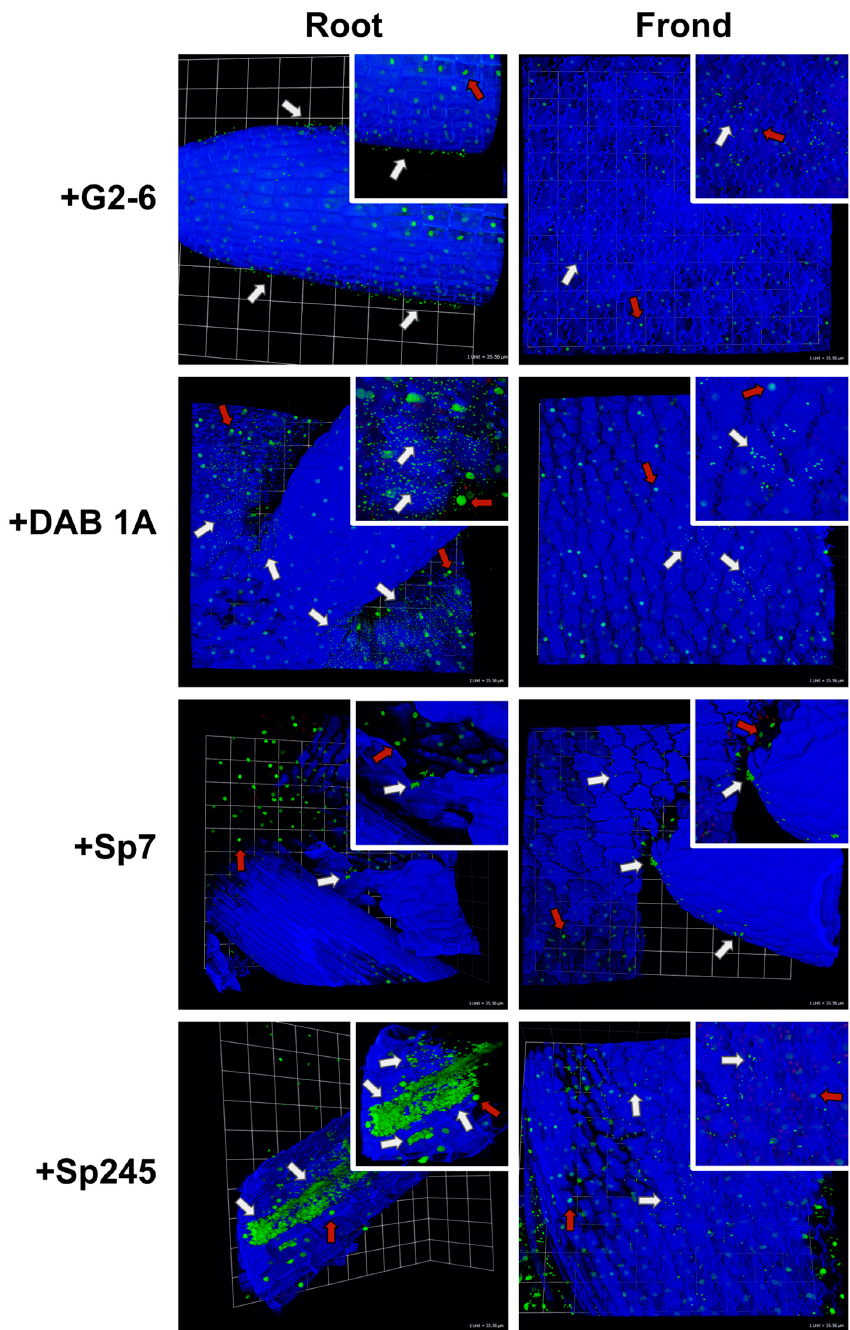
Figure 2. Two-dimensional confocal microscopy of inoculated duckweed samples. Confocal microscopy (40X/1.1 objective) was performed on inoculated Lm5576 in 0.5X SH media to characterize the spatial colonization dynamics of bacteria on duckweed. Calcofluor white was used to stain Lm5576 cellulose and visualized with the blue channel, whereas SYBR Gold was used to stain DNA and visualized with the green channel. Both bacterial and Lm5576 DNA were stained by SYBR Gold and pictured in green, but bacterial DNA (indicated by white arrows) is smaller in size than Lm5576 nuclei (indicated by red arrows), and these bacteria are often found in clustered colonies. For each main image, 1 unit of the grid scale is equal to 35.56 µm and zoomed-in images are pictured in the top-right corner. +G2-6 = Lm5576 inoculated with Bacillus simplex RUG2-6, +DAB 1A = Lm5576 inoculated with Microbacterium sp. RU370.1, +Sp7 = Lm5576 inoculated with Azospirillum brasilense Sp7, +Sp245 = Lm5576 inoculated with Azospirillum baldaniorum Sp245.